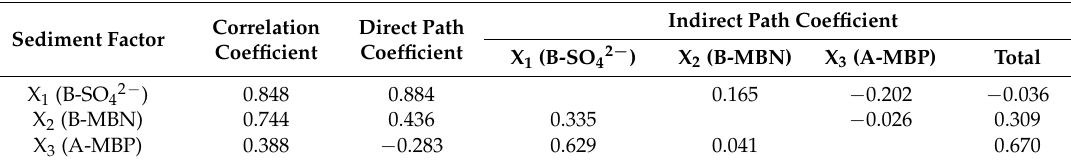
Table 7. Path coefficient of each factor on sediment phosphorus release rates.